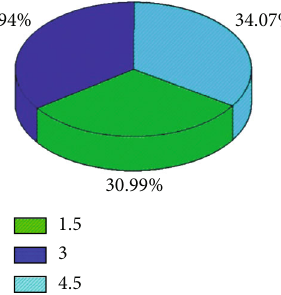
Figure 5: The contribution of silica fi ller in terms of weight percentages to tensile